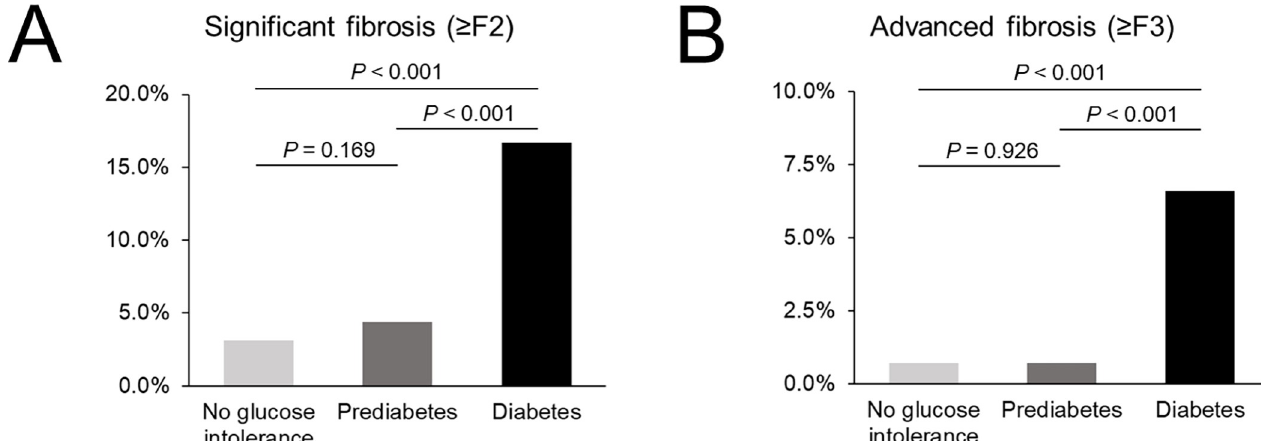
Fig 2. Significant fibrosis (A) and advanced fibrosis (B) according to glucose intolerance. � Significant fibrosis and advanced fibrosis were defined as liver stiffness measurement in magnetic resonance elastography � 2.97 kPa and � 3.62 kPa, respectively. No glucose intolerance was defined as fasting blood sugar (FBS) levels < 100 mg/dl and hemoglobin A1c (HbA1c) < 5.7%. Prediabetes was defined as FBS levels of 100 to 125 mg/dl or hemoglobin A1c (HbA1c) levels of 5.7% to 6.4%. Diabetes mellitus was defined as FBS � 126 mg/dL or hemoglobin A1c (HbA1c) � 6.5% or treatment with anti-diabetic